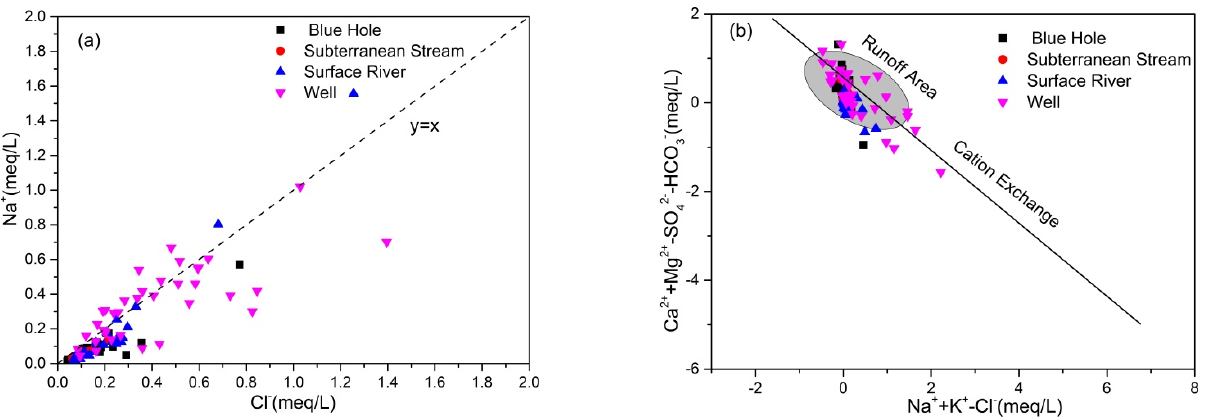
Figure 8. Relationships between major ions in the water of the Huixian karst wetland. ( a ) Cl − vs. Na + , ( b ) Na + + K + − Cl − vs. Ca 2+ + Mg 2+ − SO 42 − − HCO 3 − .